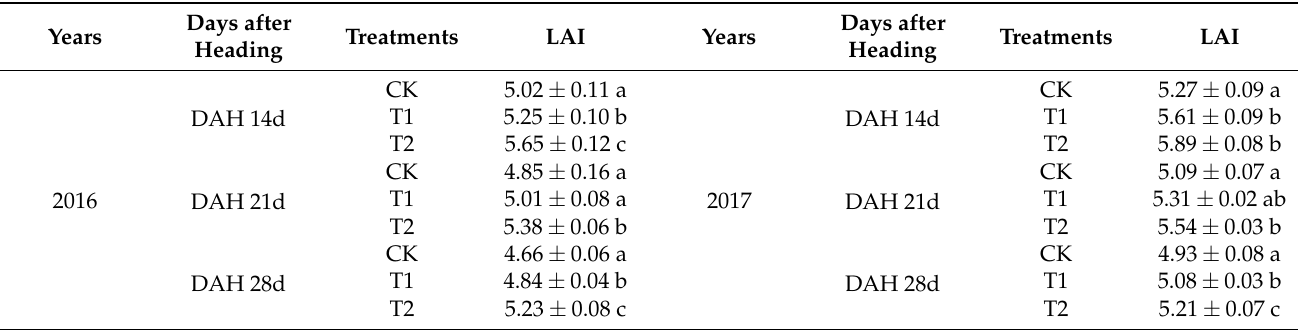
Table 4. The LAI values of rice under different treatments at different periods after heading, in 2016–2017.